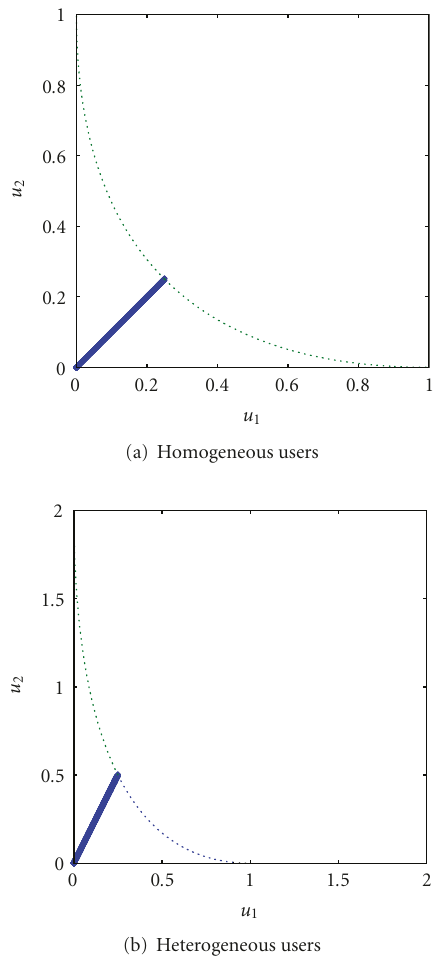
Figure 5: Payo ff s that can be achieved by the manager who observes only the aggregate probability. (a) Homogeneous users with k 1 = k 2 = 1. (b) Heterogeneous users with k 1 = 1 and k 2 = 2.